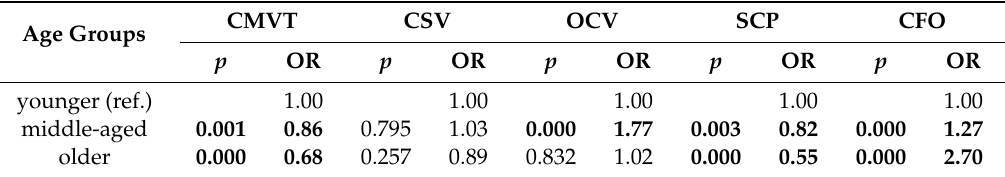
Table 6. Odds ratio results for di ff erent crash types between the examined age groups based on the data after using SMOTE + ENN.